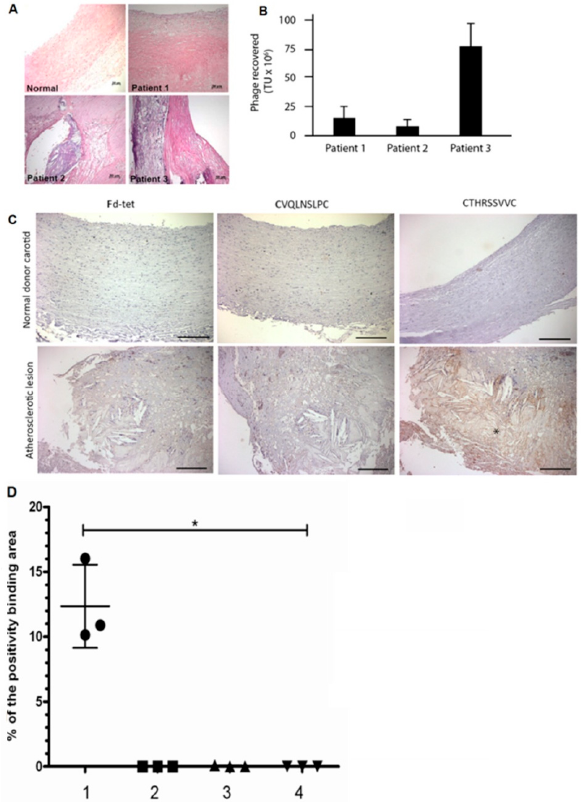
Figure 1. Phages displaying the peptide sequence CTHRSSVVC bind to human atherosclerotic lesions. ( A ) hematoxylin–eosin (HE) staining to human samples. Bar, 50 µm in all panels; ( B ) Phage recovery from CX7C peptide phage library after each round of biopanning in atheroma from each patient. Error bars indicate standard error of mean (SEM); ( C ) Phage Overlay Assay to atheroma and normal donor carotid tissue samples ( n = 3, each group), figure shows representative slides of immunohistochemical staining for CTHRSSVVC-phage (CD163-mimic) and CVQLNSLPC-phage (Galectin-4 mimic) in the normal carotid ( top ) and atherosclerotic lesion from patient 2 ( bottom ), with a strong positively stained to lipid core region (hemorrhage, thrombus and cholesterol crystals) are indicated by the star ( * ). Bar, 100 µm in all panels; ( D ) Quantification of binding phage in human atheroma and normal carotid ( n = 3, each group), was carried out in twelve samples that were divided in four different groups: ( 1 ) Atheroma with CTHRSSVVC-phage; ( 2 ) Atheroma with Fd-phage; ( 3 ) Normal carotid with CTHRSSVVC-phage; and ( 4 ) Normal carotid with Fd-phage. Statistical difference was determined by one-way analysis of variance followed by the Kruskal–Wallis test, and it was accepted at a value of * p < 0.05, vs. normal